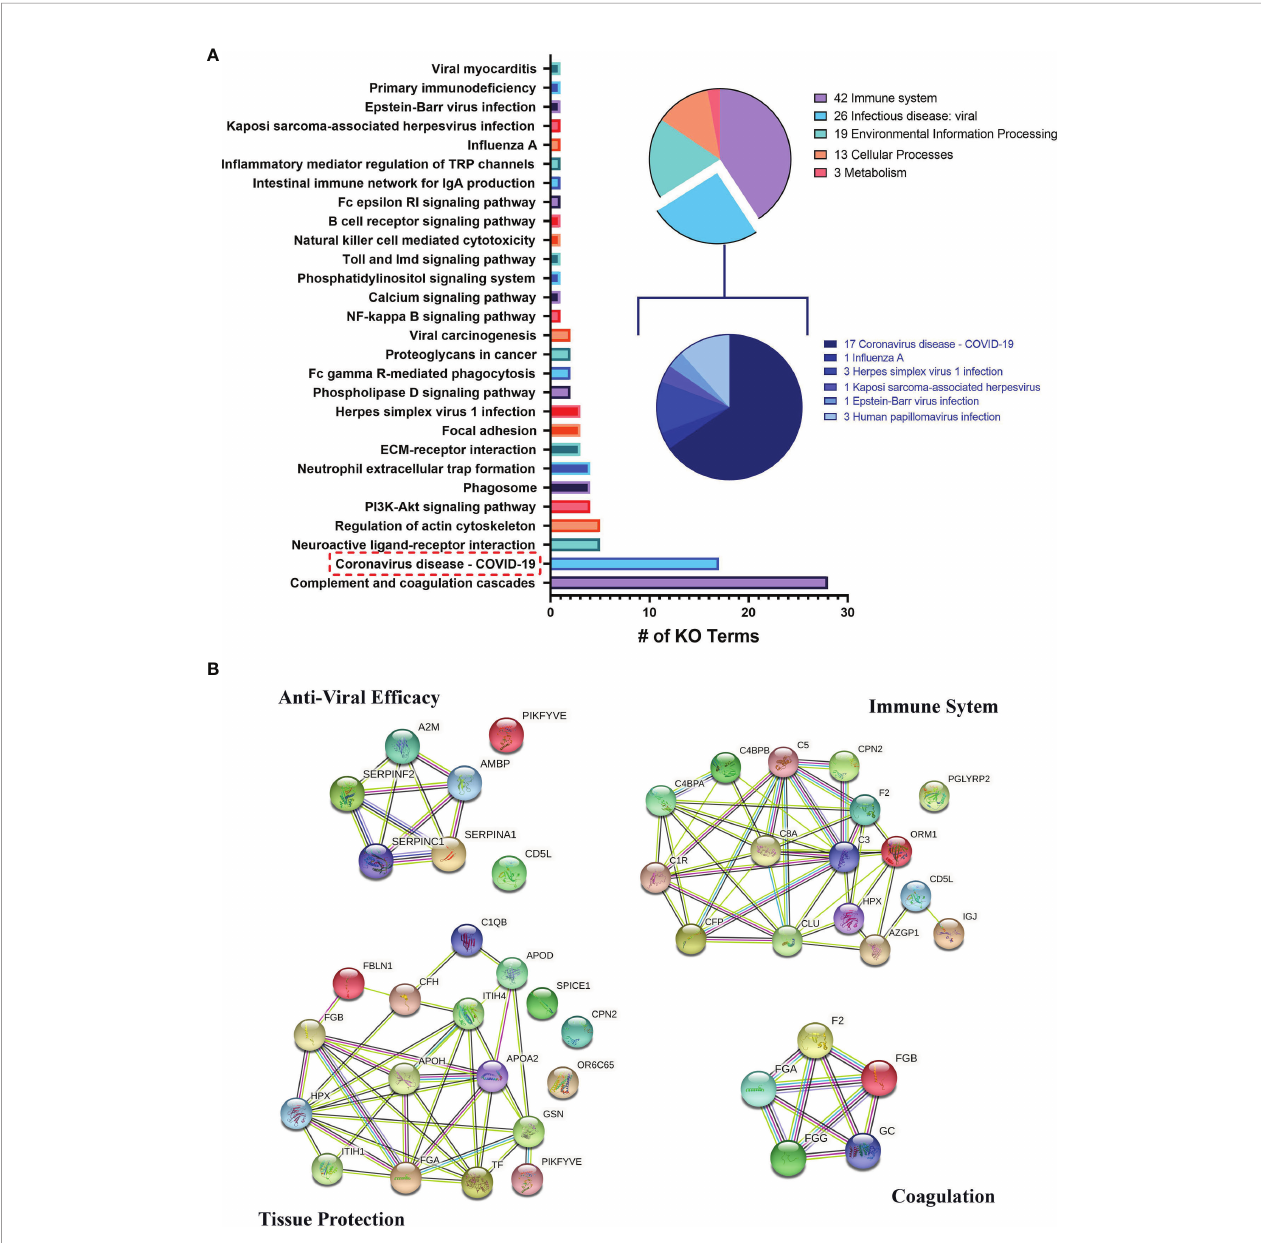
FIGURE 4 | (A) KEGG Ontology (KO) data of proteomic analysis of ChipEXO. (B) STRING relation scheme of the ChipEXO protein-enriched